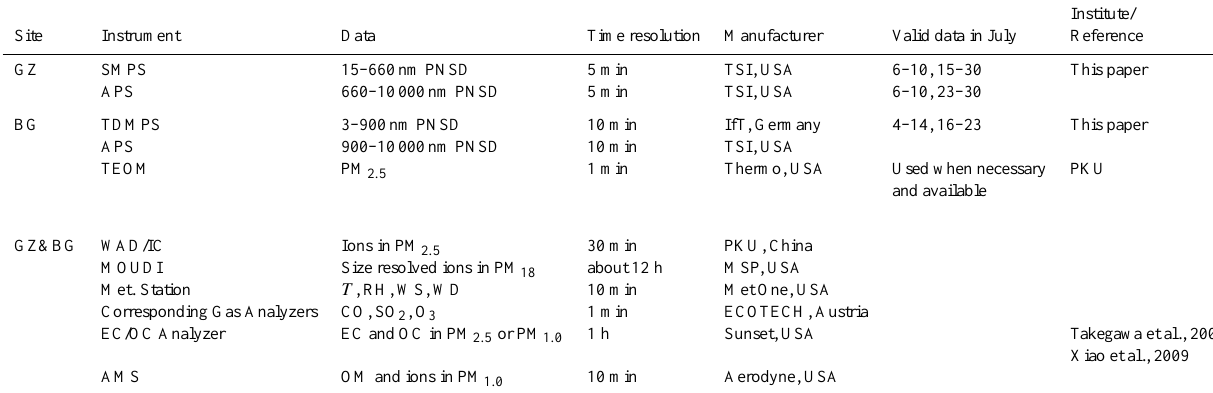
Table 1. Measurement of particle number size distributions and other parameters at GZ and